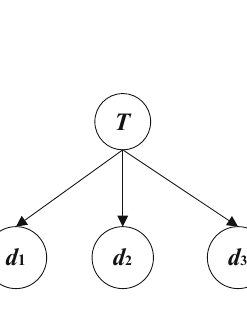
Fig. 5 Bayesian network structure of sea ice disaster in the Bohai Sea region of China